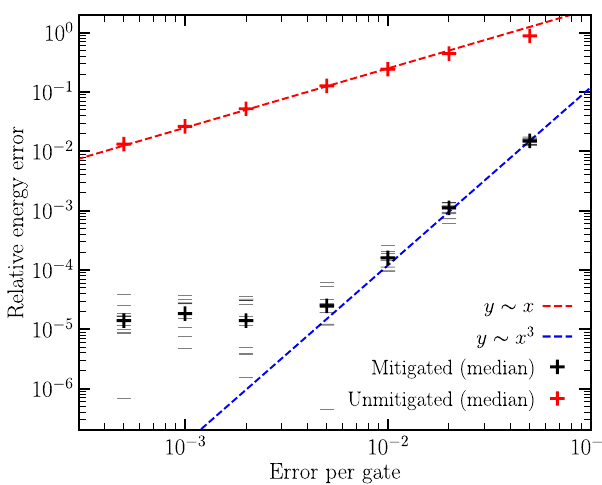
FIG. 10. Error in estimating the ground state energy of a free-fermion system [Eq. (58) of the main text] of four fermions (on four qubits), using control-free verified phase estimation and a VQE. Noise model is a mixture of ampli- tude and phase damping and constant two-qubit control error (details in the text). Median absolute errors for both verified estimation (black crosses) and standard partial state tomogra- phy (red crosses) are calculated over ten different optimiza- tion attempts. Individual simulations are plotted behind (faint dashes). Each optimization starts from a different parameter set. Linear (red dashed) and cubic (blue dashed) lines are shown as guides.